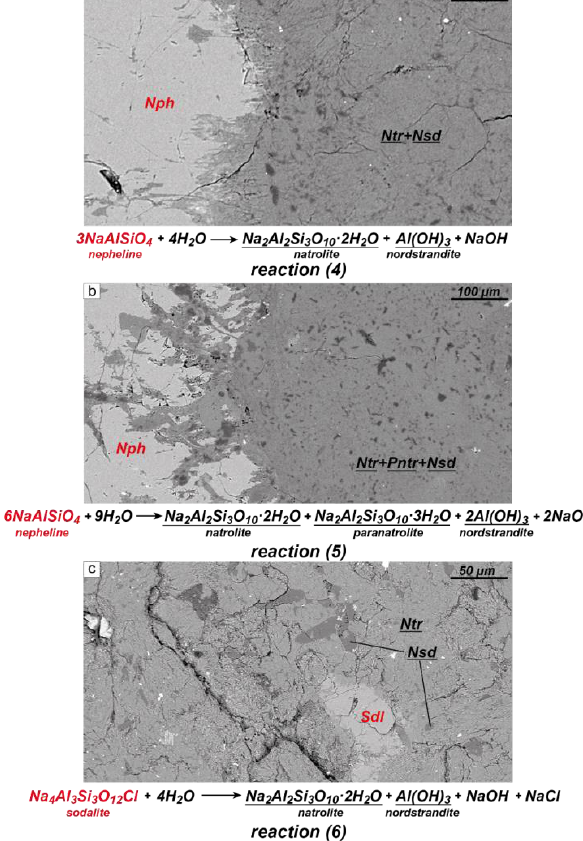
Figure 9. Proposed substitution reactions for nepheline and sodalite via an association of secondary minerals. ( a ) Replacement of nepheline with natrolite and nordstrandite (sample LV-319A, see also Figure 3); ( b ) replacement of nepheline with natrolite, paranatrolite, and nordstrandite (sample LV-319G, see also Figure 5 a,b); ( c ) replacement of sodalite with natrolite and nordstrandite (sample LV-356/3, see also Figure 6 e,f). BSE images.